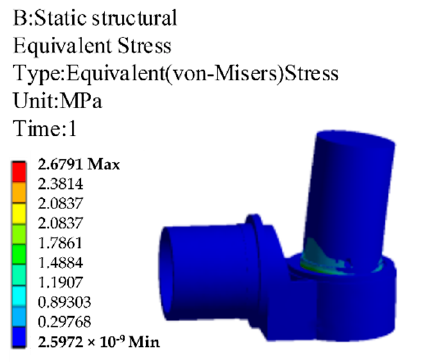
Figure 11. The milling stress nephogram of the maximum deformation position.